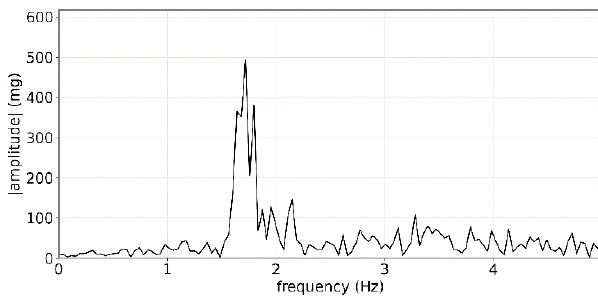
Figure 3. Measurement of Respiration Rate (RR) of a cow subject to heat Figure 3: Measurement of Respiration Rate (RR) of a cow subject to heat stress.